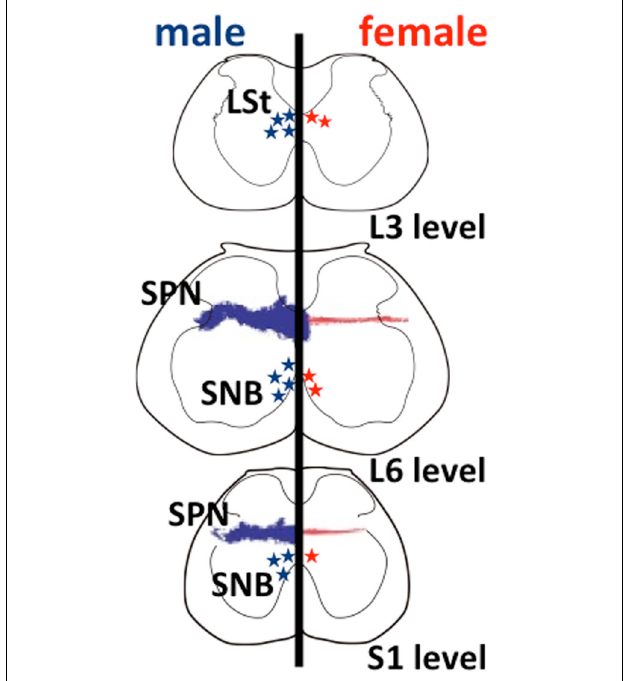
FIGURE 1 | Schematic drawings of neural sexual dimorphisms in the rodent lumbar spinal cord. The spinal levels are indicated on the lower right. Anatomical features in males and in females are shown on the left and right hemispheres, respectively. Sexually dimorphic cell numbers and axonal projections in the spinal cord are shown by stars and fine dots (males in blue; females in red), respectively. The density of the symbols is proportional to the relative density of the sexual dimorphisms in the spinal cord. L, lumbar; S, sacral; LSt, lumbar spinothalamic neurons; SNB, spinal nucleus of the bulbocavernosus; SPN, sacral parasympathetic nucleus.